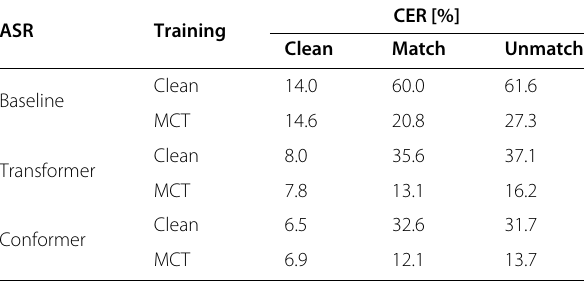
Table 2 CER [%] results of the ASR system trained by clean data and multi-condition training (MCT) without the